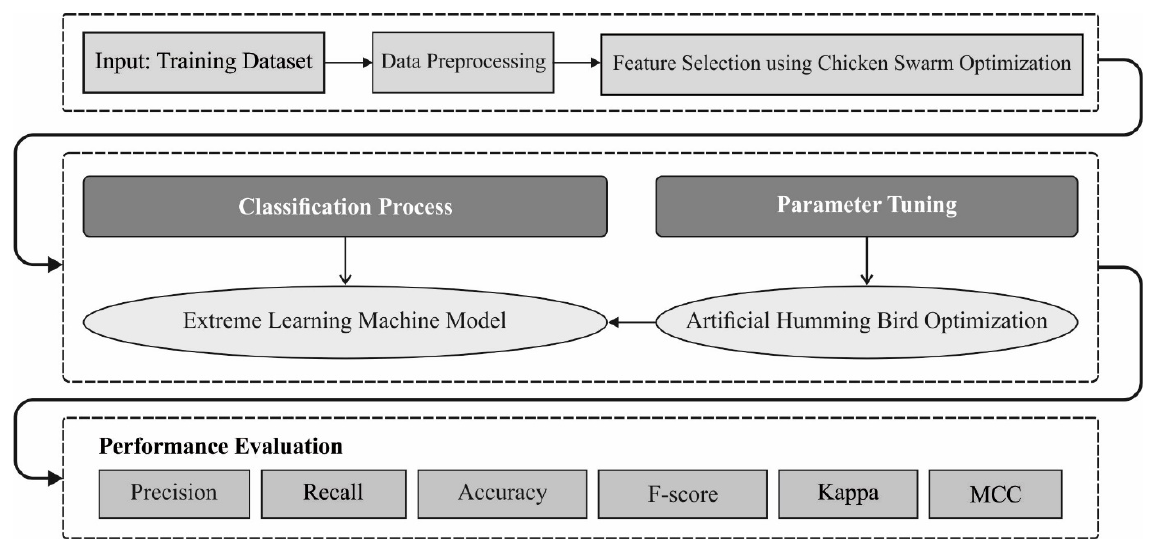
Figure 1. Block diagram of FSSML-EDM technique.